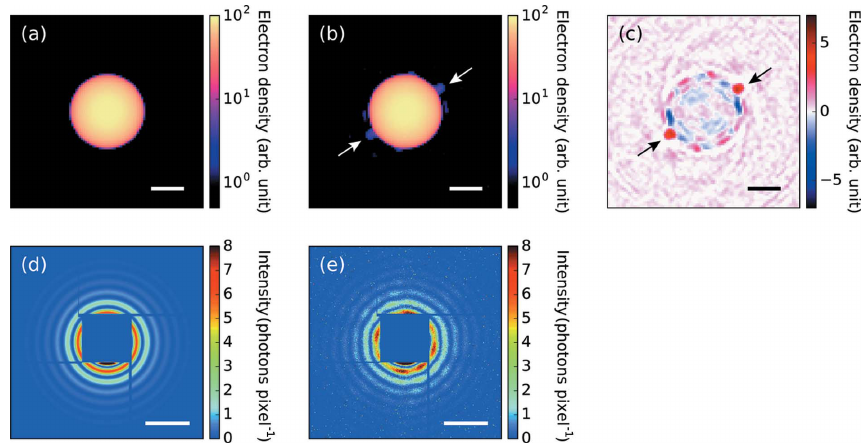
Figure 6 Result of the structure reconstruction from the measured diffraction pattern [Fig. 1( c )] using the implemented algorithm. ( a ) A projection of a uniform dense sphere used as the initial estimate of the density map. ( b ) The reconstructed density map by the implemented algorithm. ( c ) The difference between ( a ) and ( b ) defined as ( b ) (cid:4) ( a ). ( d ) The simulated pattern from ( a ). ( e ) The simulated pattern from ( b ). The scale bars in ( a )–( c ) are 100 nm and those in ( d )–( e ) are 0.1 nm (cid:4) 1